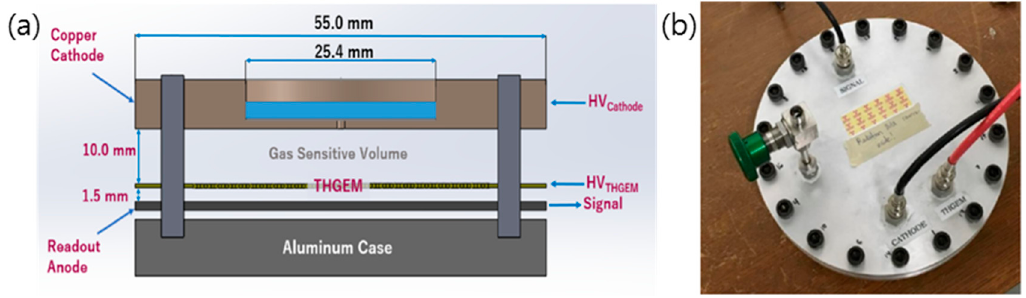
Figure 32. ( a ) THGEM detector composition and ( b ) aluminum chamber [100].